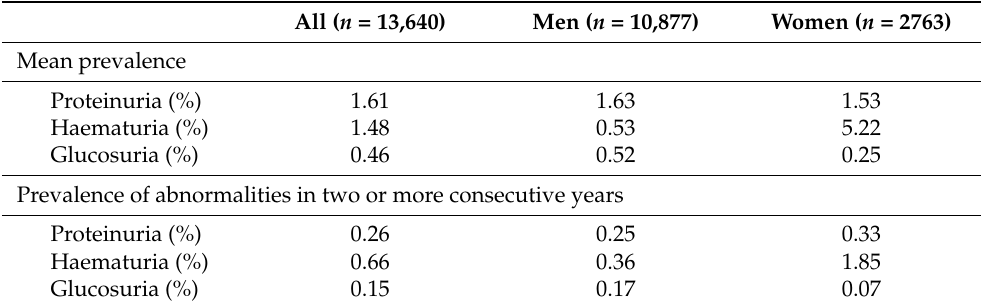
Table 2. The mean prevalence and the prevalence of abnormalities in two or more consecutive years of proteinuria, haematuria and glucosuria. All ( n = 13,640) Men ( n = 10,877) Mean prevalence Proteinuria (%)